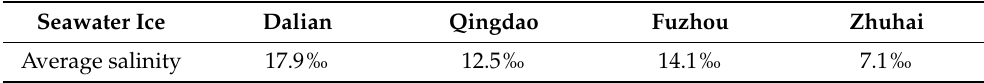
Table 2. Average salinity of the seawater ice sample after the shear strength test.